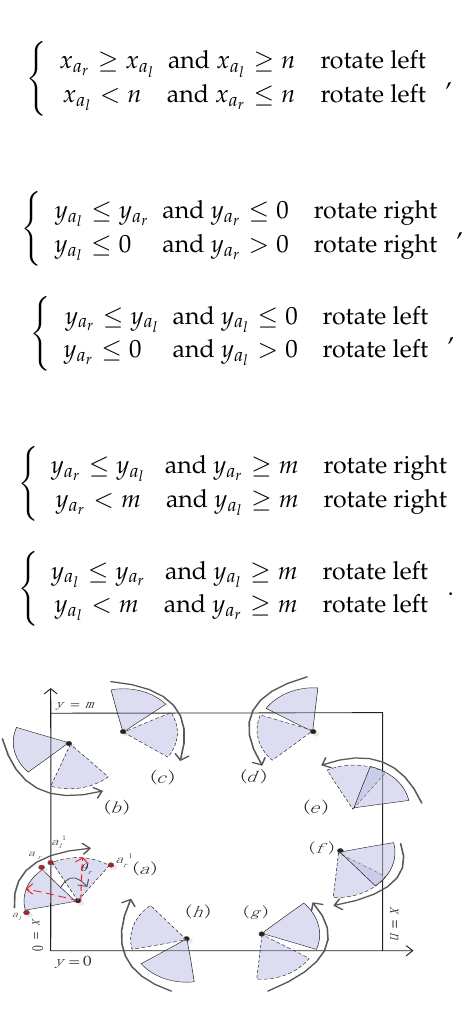
Figure 6. Rotation based on boundary. ( a ) boundary x = 0, rotate right; ( b ) boundary x = 0, rotate left; ( c ) boundary y = m , rotate right; ( d ) boundary y = m , rotate left; ( e ) boundary x = n , rotate left; ( f ) boundary x = n , rotate right; ( g ) boundary y = 0, rotate left; ( h ) boundary y = 0, rotate right.